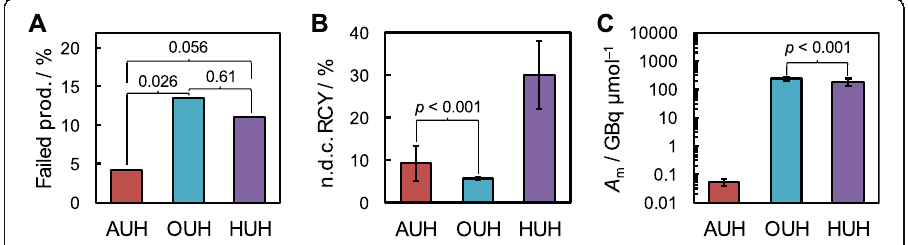
Fig. 1 Production parameters for the three radiopharmaceutical production sites. A Percentage of failed productions. B Average non-decay corrected RCYs. C Average molar activity during the time period considered (note the log-scale on the ordinate). In ( A ) the numbers indicate the calculated p -values. In ( B ) and ( C ), a p -value in only given for the least different